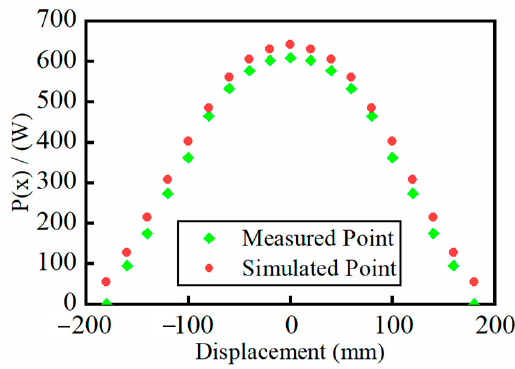
Figure 11. Comparison of measured and simulated transfer power.